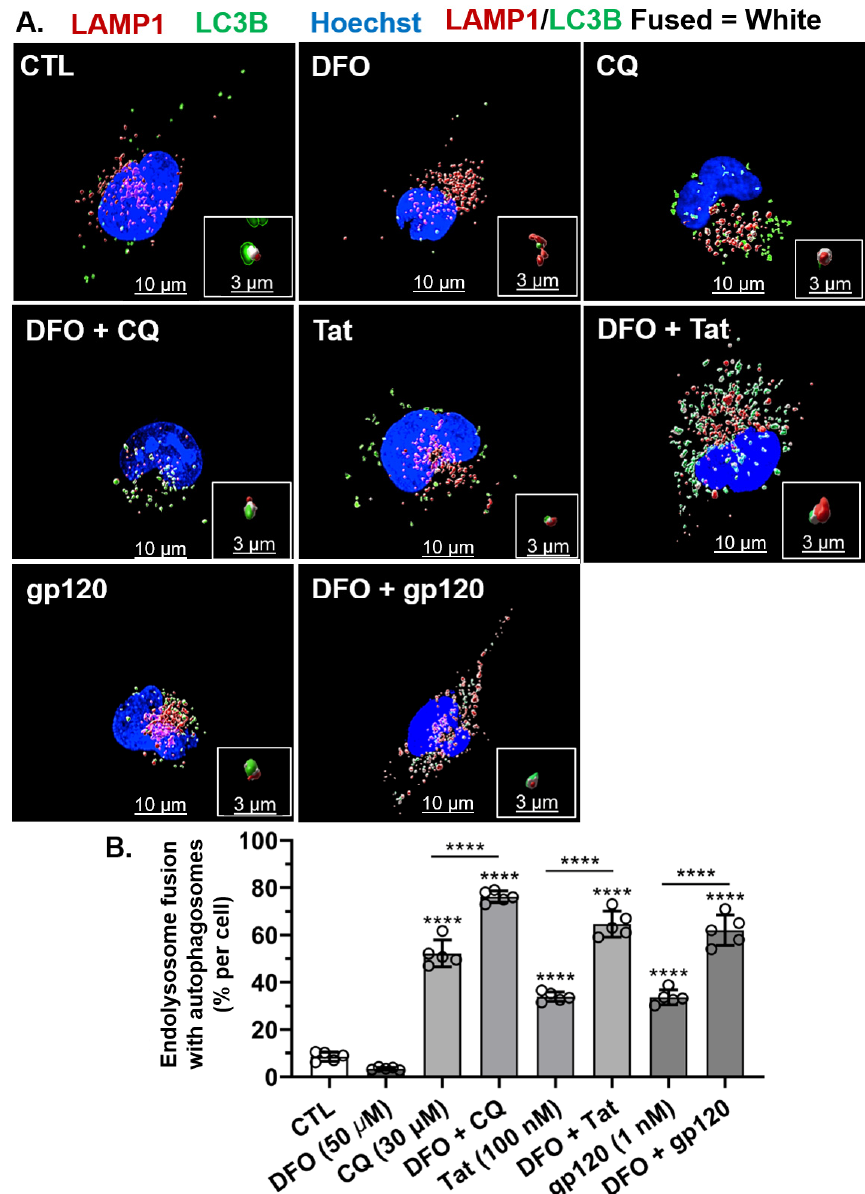
Figure 6. DFO increased HIV ‐ 1 Tat ‐ , gp120 ‐ , and CQ ‐ induced increases in endolysosome fusion with autolysosomes. ( A ) Representative fluorescence microscopy reconstructed (using Imaris 3D software) images showing autophagosomes (green puncta), endolysosomes (red puncta), endolysosomes fused with autolysosomes (white puncta), and nuclei (blue). Qualitatively, DFO increased autophagosome fusion with endolysosomes induced by CQ (30 μ M), Tat (100 nM), and gp120 (1 nM). ( B ) Quantitatively, DFO increased the percentage of endolysosomes fusing with autophagosomes per cell induced significantly ( p < 0.0001) by CQ (30 μ M), Tat (100 nM), and gp120 (1 nM). Image analysis and quantification was performed from five independent experiments with 30 cells quantified for each experimental condition ( n = 150). Error bars represent standard deviation (SD) of five independent experiments. A one ‐ way ANOVA multiple comparisons test was used to compare the control group and treatment groups. Cells were chosen randomly during image acquisition and analysis from the microscope field of view, and no cells were intentionally excluded. Scale bars are 10 μ m for the image and 3 μ m for the inset. **** p < 0.0001 .